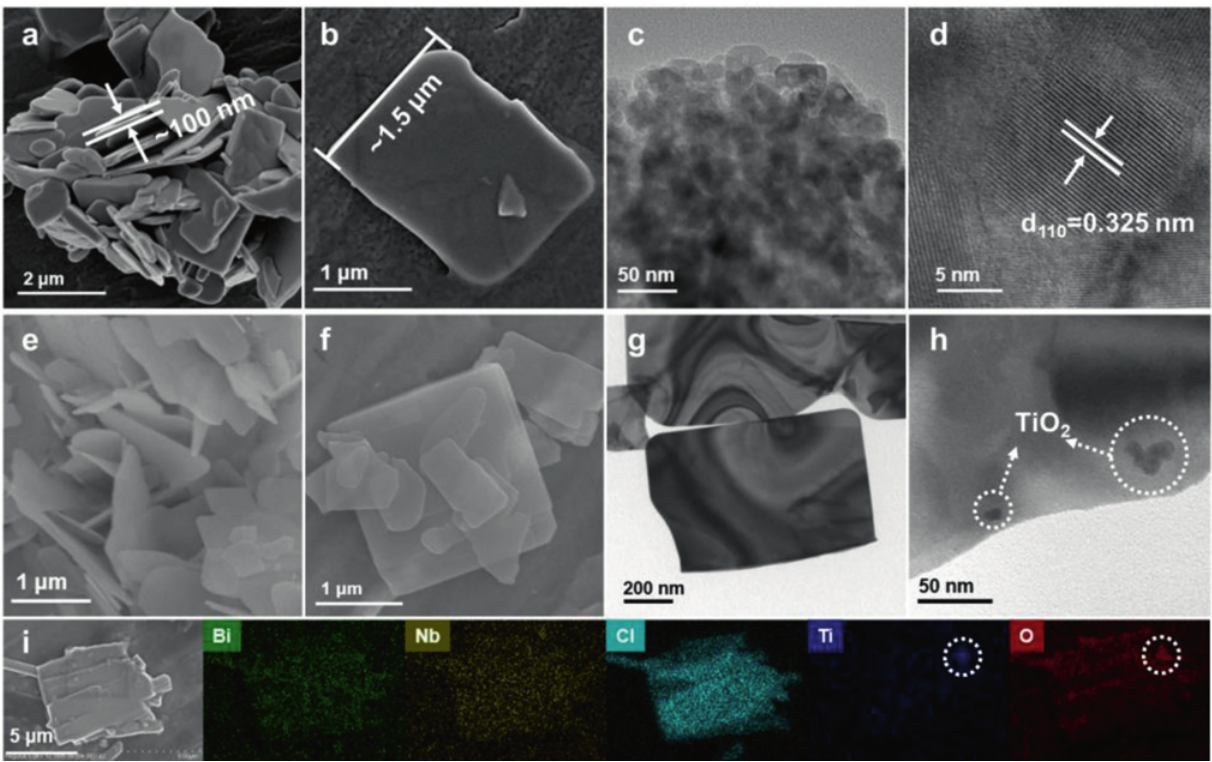
Figure2: (a,b)SEMimagesofpristineBNC,(c,d)TEMandHRTEMimagesofC-TiO 2 ,(e,f)SEMimagesofT/BNC-1,(g,h)TEMimagesofT/BNC-1 and (i) EDS mapping for Bi, Nb, Cl, Ti and O elements for